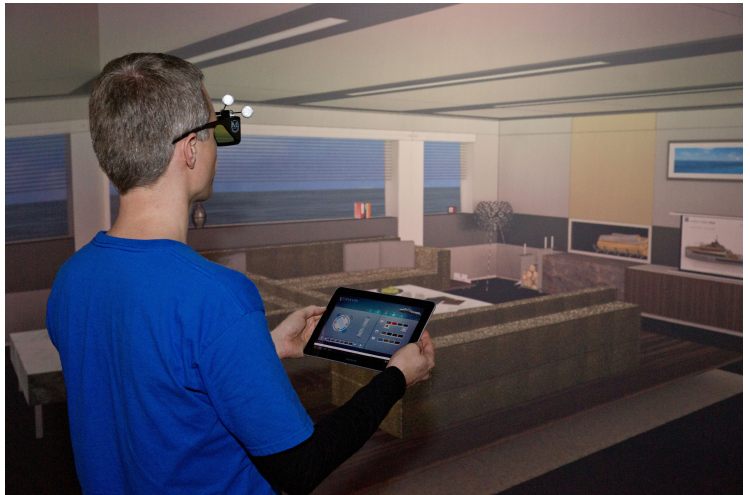
Figure 1. The “usual” test case for a virtual reality environment is a product evaluation, i.e., inspecting and evaluating a product such as a building, a car, a yacht, etc., in order to obtain a realistic impression of the final